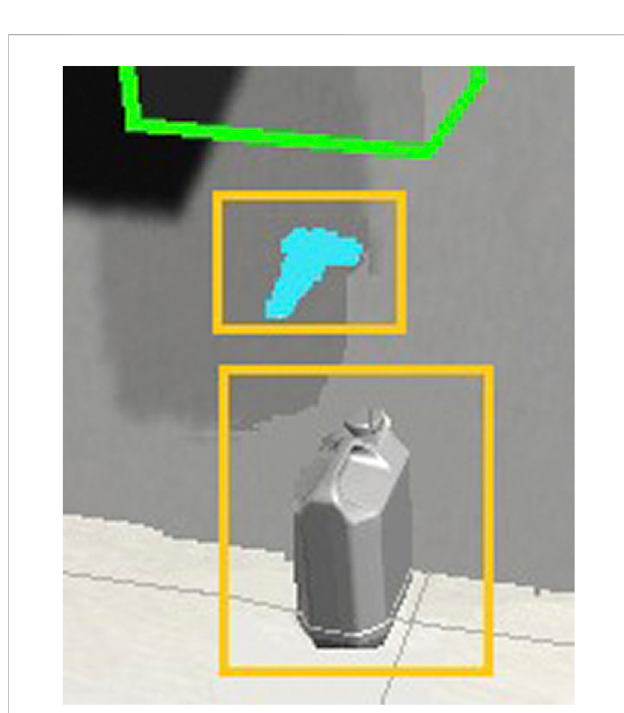
FIGURE 2 Incongruous conditions: visual discrepancy caused by differences inposition/velocitybetweenthecontroller andtheobject,highlightedin yellow